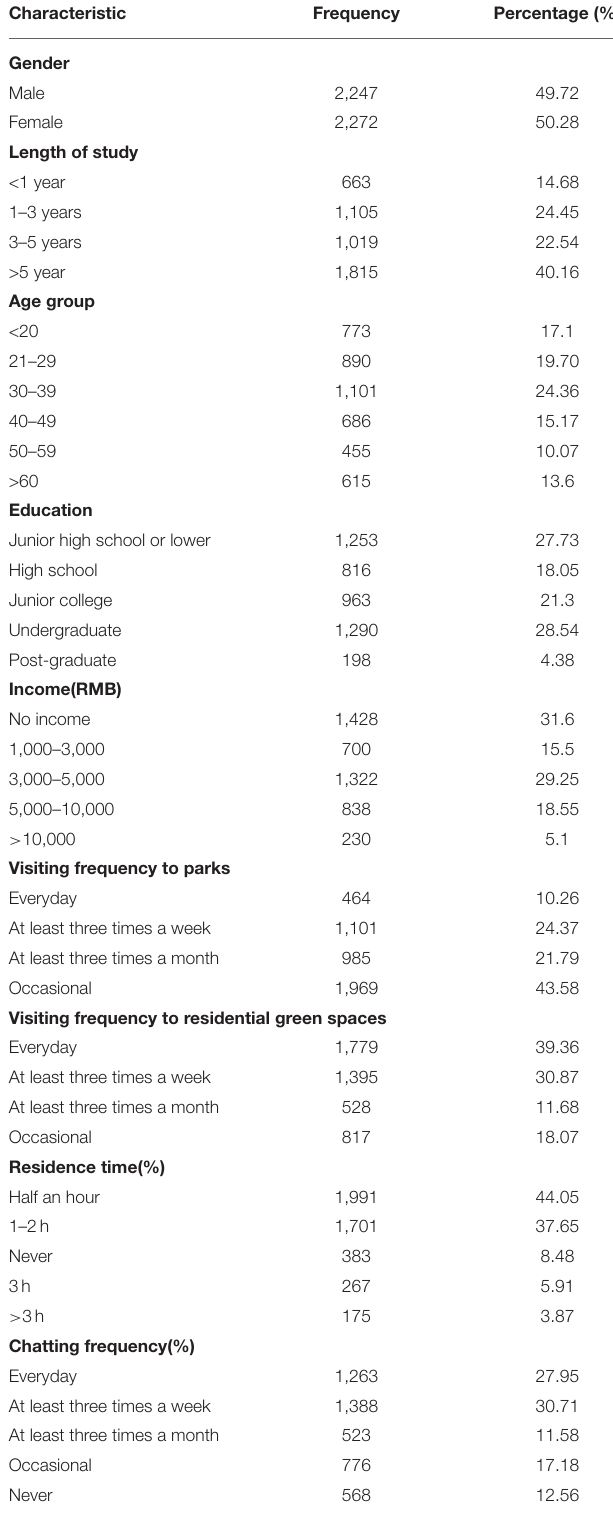
TABLE 2 | Respondents’ demographic characteristics and use of residential green